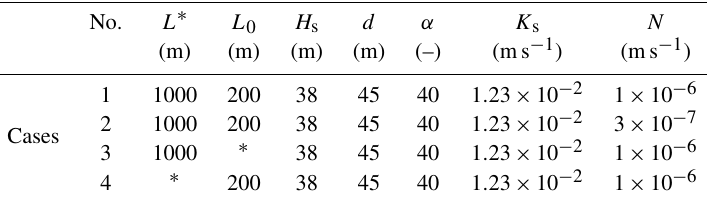
Table 1. List of parameters use in different simulations.